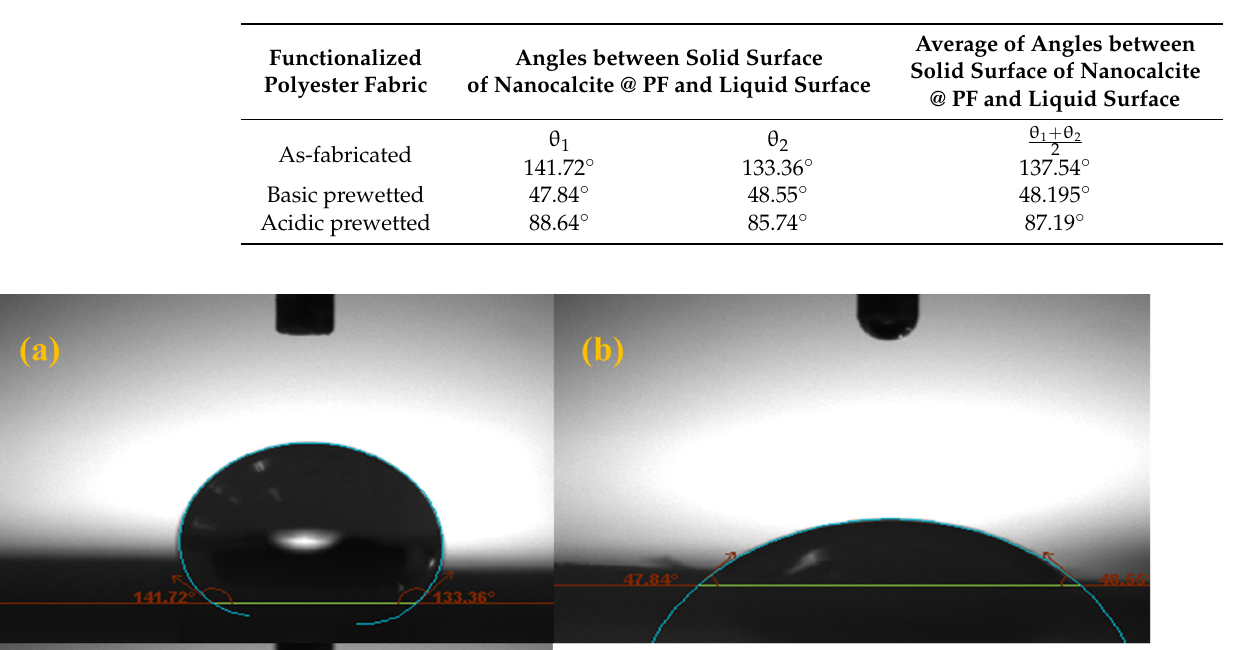
Table 2. Alteration of the water contact angle of the as-fabricated and after acidic and basic prewetted